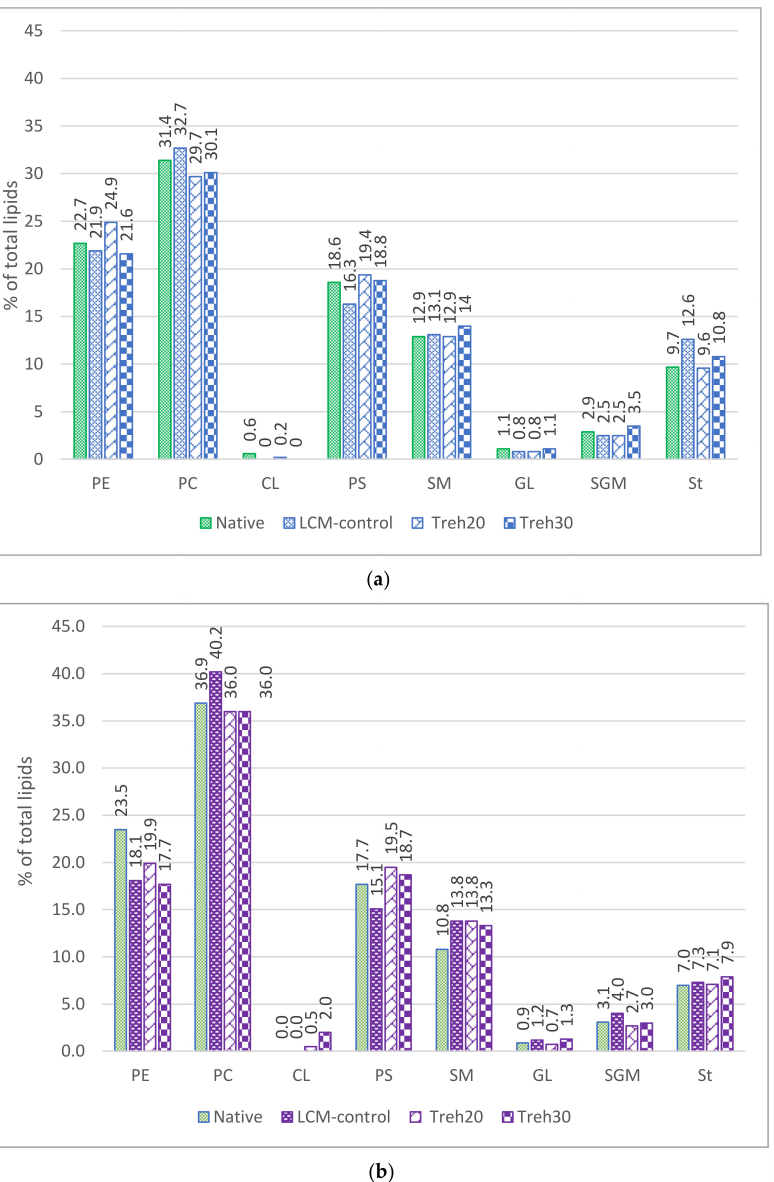
Figure 1. The composition of membrane lipids of spermatozoa of native and frozen/thawed rooster semen depending on the breed and the composition of the cryoprotective diluent: ( a ) native and frozen/thawed TS; ( b ) native and frozen/thawed